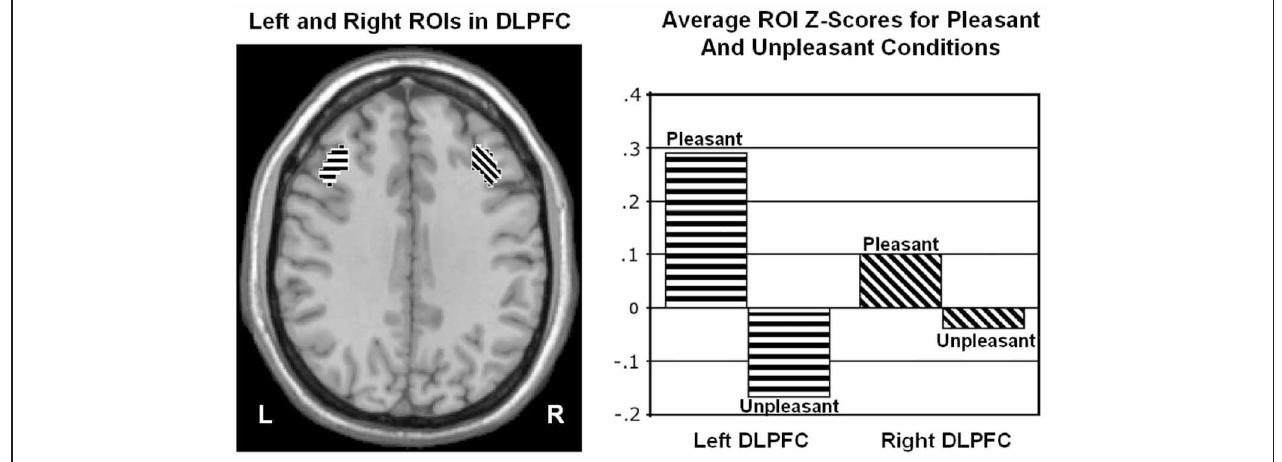
Right panel : Mean z scores for pleasant and unpleasant word conditions in left and right DLPFC. From Herrington et al. (2005). Copyright by the American Psychological Association. Reprinted with